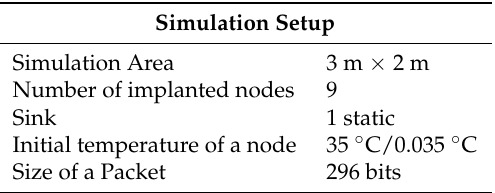
Table 2. Simulation